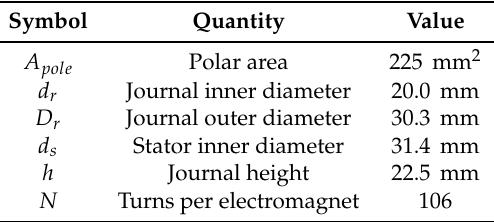
Table 1. Main parameters of the test rig.